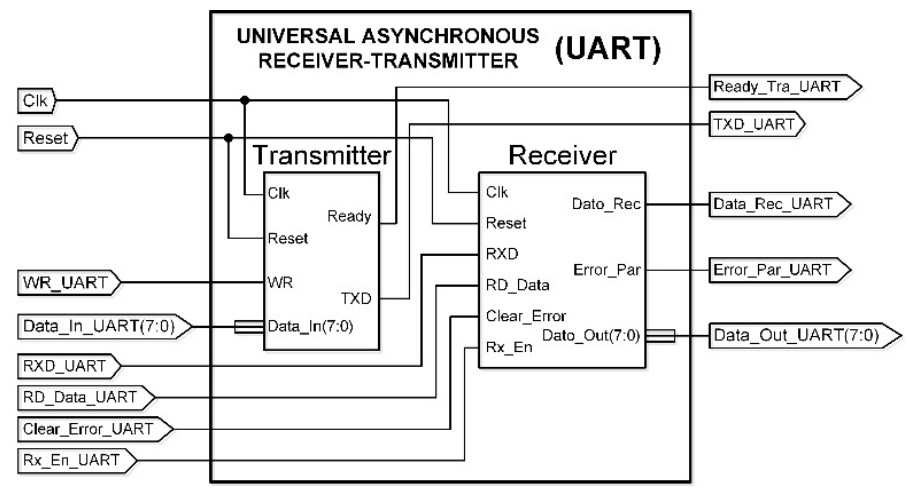
Figure 7. Universal Asynchronous Receiver–Transmitter (UART) Entity.